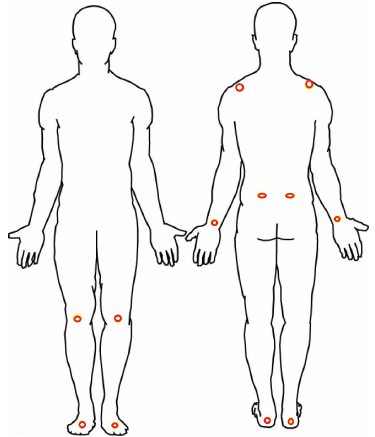
Figure 1. Red circles show the location of the retroreflective markers.